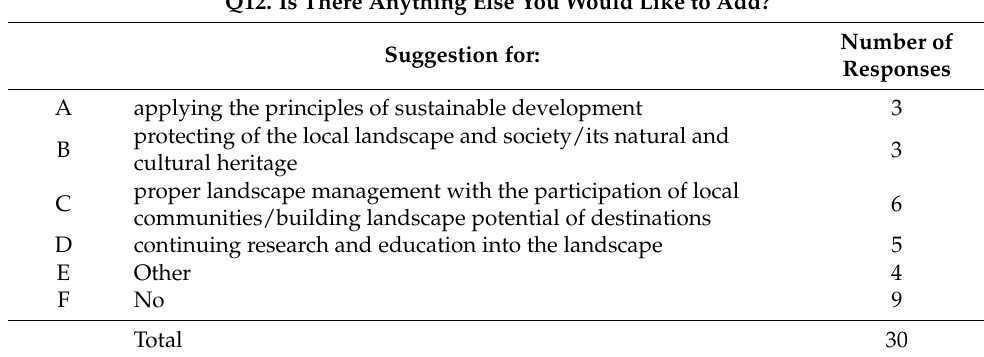
Table 6. Additional